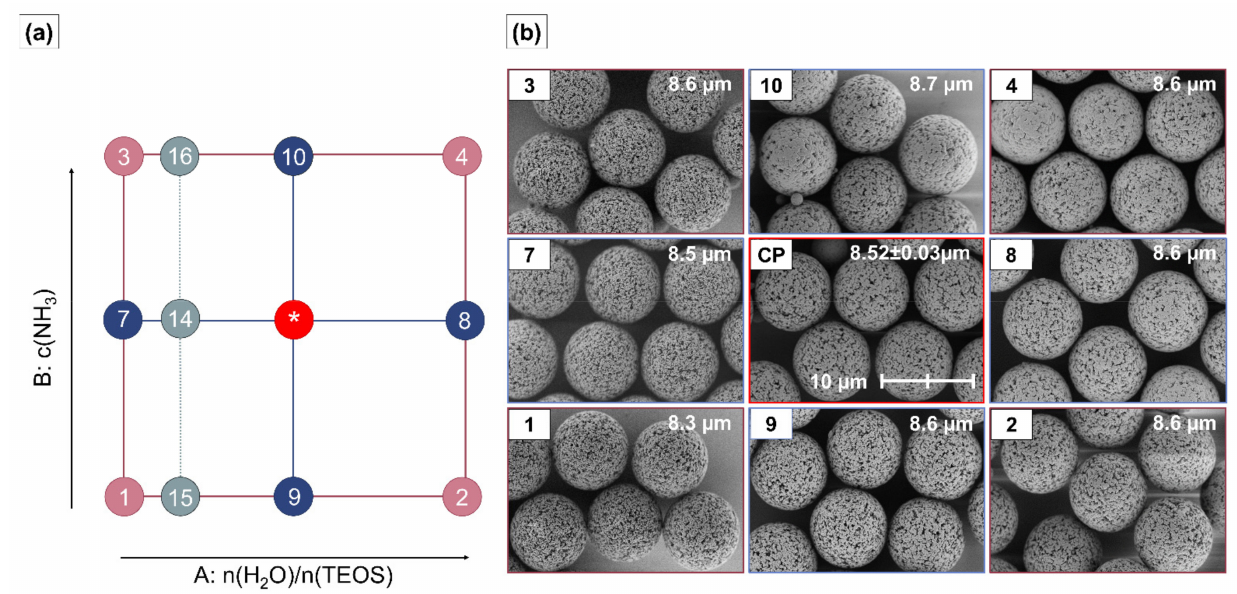
Figure 1. ( a ) Illustration of the face-centered-central composite design including the additional points HB14–16 ( b ) Systematic overview over SEM images at 5000 × magnification of HBs. The median size of each sample is indicated in the respective image corner. For the CPs, the average particle size and its standard deviation over all five samples is given. The SEM image of HB13 is shown as a representative example for the CPs. Factorial design points (HB1–4) are displayed in dark red, center points (CPs) are displayed in red (HB5–6, HB11–13), axial design points (HB7–10) are displayed in blue and additional design points are shown in grey (HB14–16). SEM images of the additional design points HB14–16 are shown separately in Appendix B Figure A1. * indicates the center point experiments at intermediate factor level settings. Table 1. Factor-level settings and their corresponding particle properties particle size, dispersity, specific surface area, pore diameter, pore volume (at p/p 0 = 0.95), SiO 2 content and size of the SNPs. The experiments are listed according to Yates standard order (Std). * Outlier-HB9 is marked in italics and was not included in the model building. † No SNPs visible or not measurable (below image resolution of